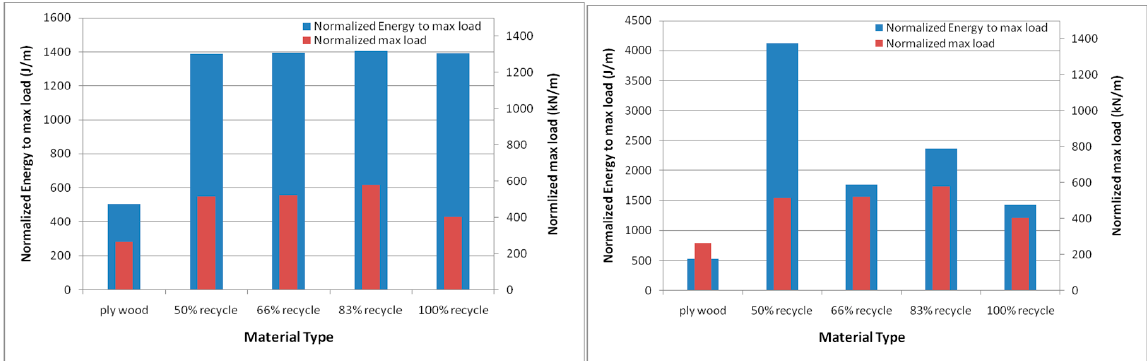
Figure 18. Low Velocity Impact (LVI) response of PP-GF with different percentages of recycled content; ( left )—6 J impact; ( right )—24 J impact. In total, 100% recyclate is the as-received PP-GF scrap.